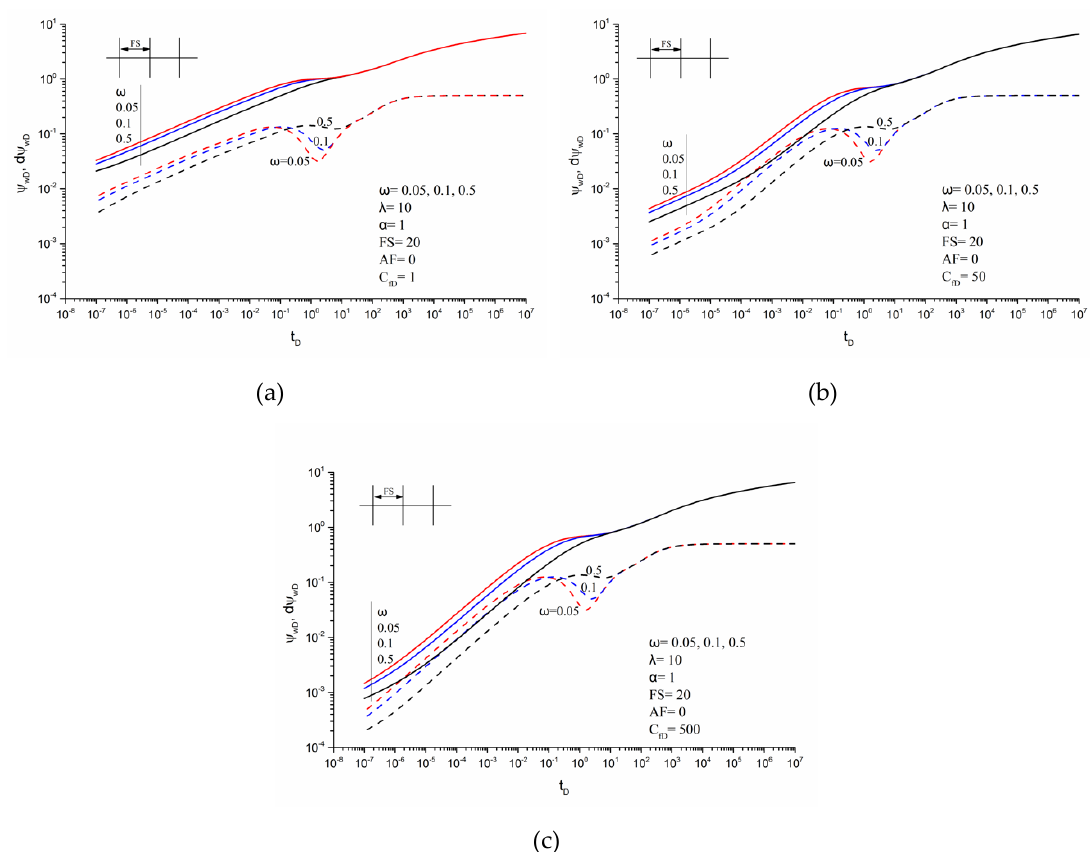
Figure 7. The typical pseudo-pressure curves of a multi-fractured horizontal well with different storability ratios. ( a ) Low conductivity; ( b ) intermediate conductivity; ( c ) high conductivity. Table 1. The pseudo-pressure and pseudo-pressure derivative data for di ff erent storability